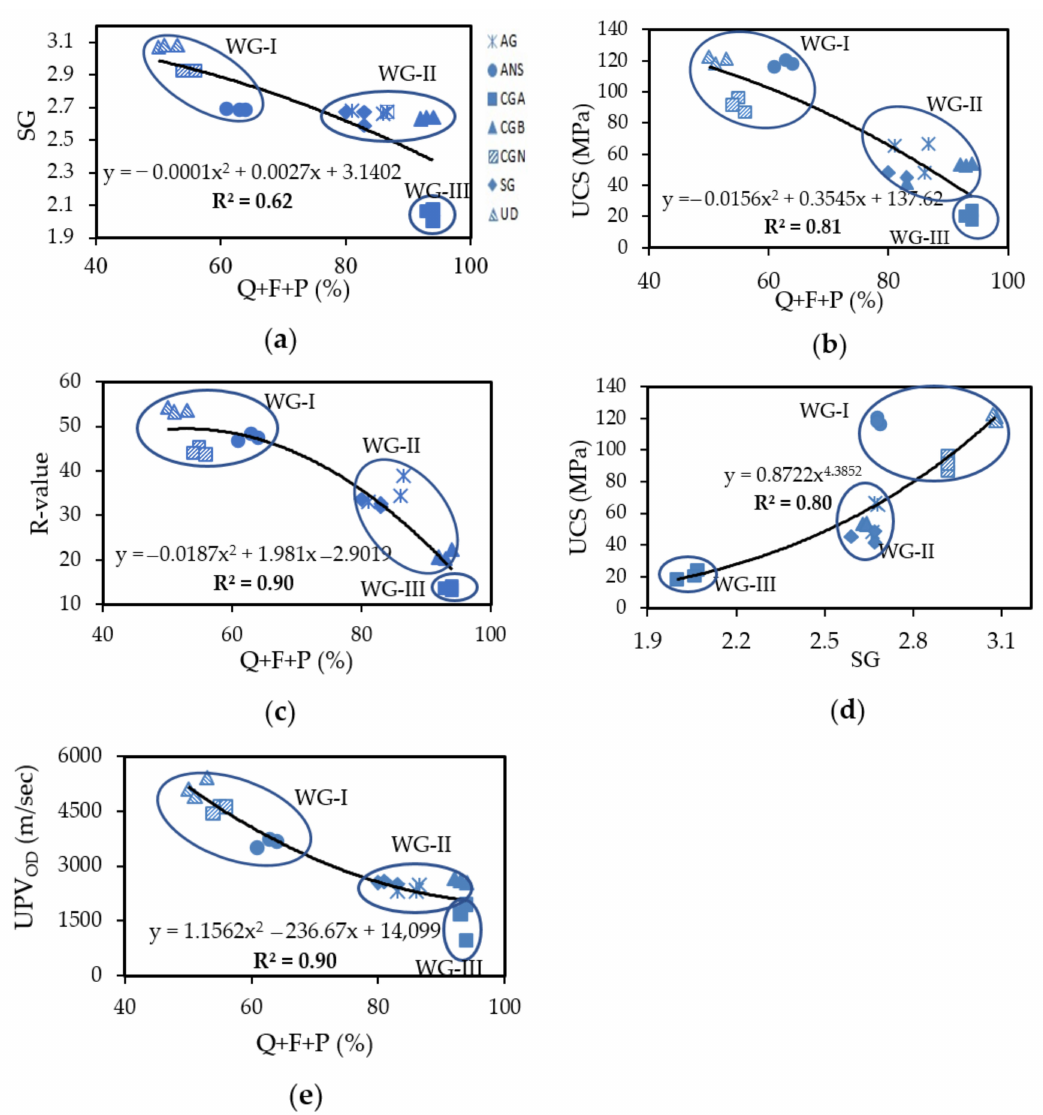
Figure 4. Correlation plots of ( a ) cumulative percentage of quartz, feldspar, and plagioclase (Q + F + P) vs. specific gravity (SG) (polynomial), ( b ) Q + F + P vs. unconfined compressive strength (UCS) (polynomial), ( c ) UCS vs. SG, ( d ) Q + F + P vs. R-value (polynomial), ( e ) Q + F + P vs. ultrasonic pulse velocity oven-dry (UPV OD) (polynomial). Symbols given in ( a ) are the same for all